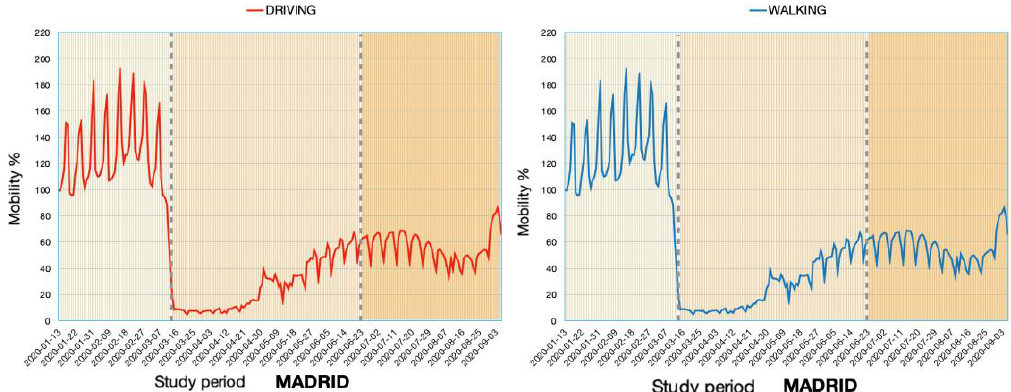
Figure 8. Mobility evolution in Madrid from January until September 2020. Source: Own elaboration with data collected from Apple’s mobility trend [22].